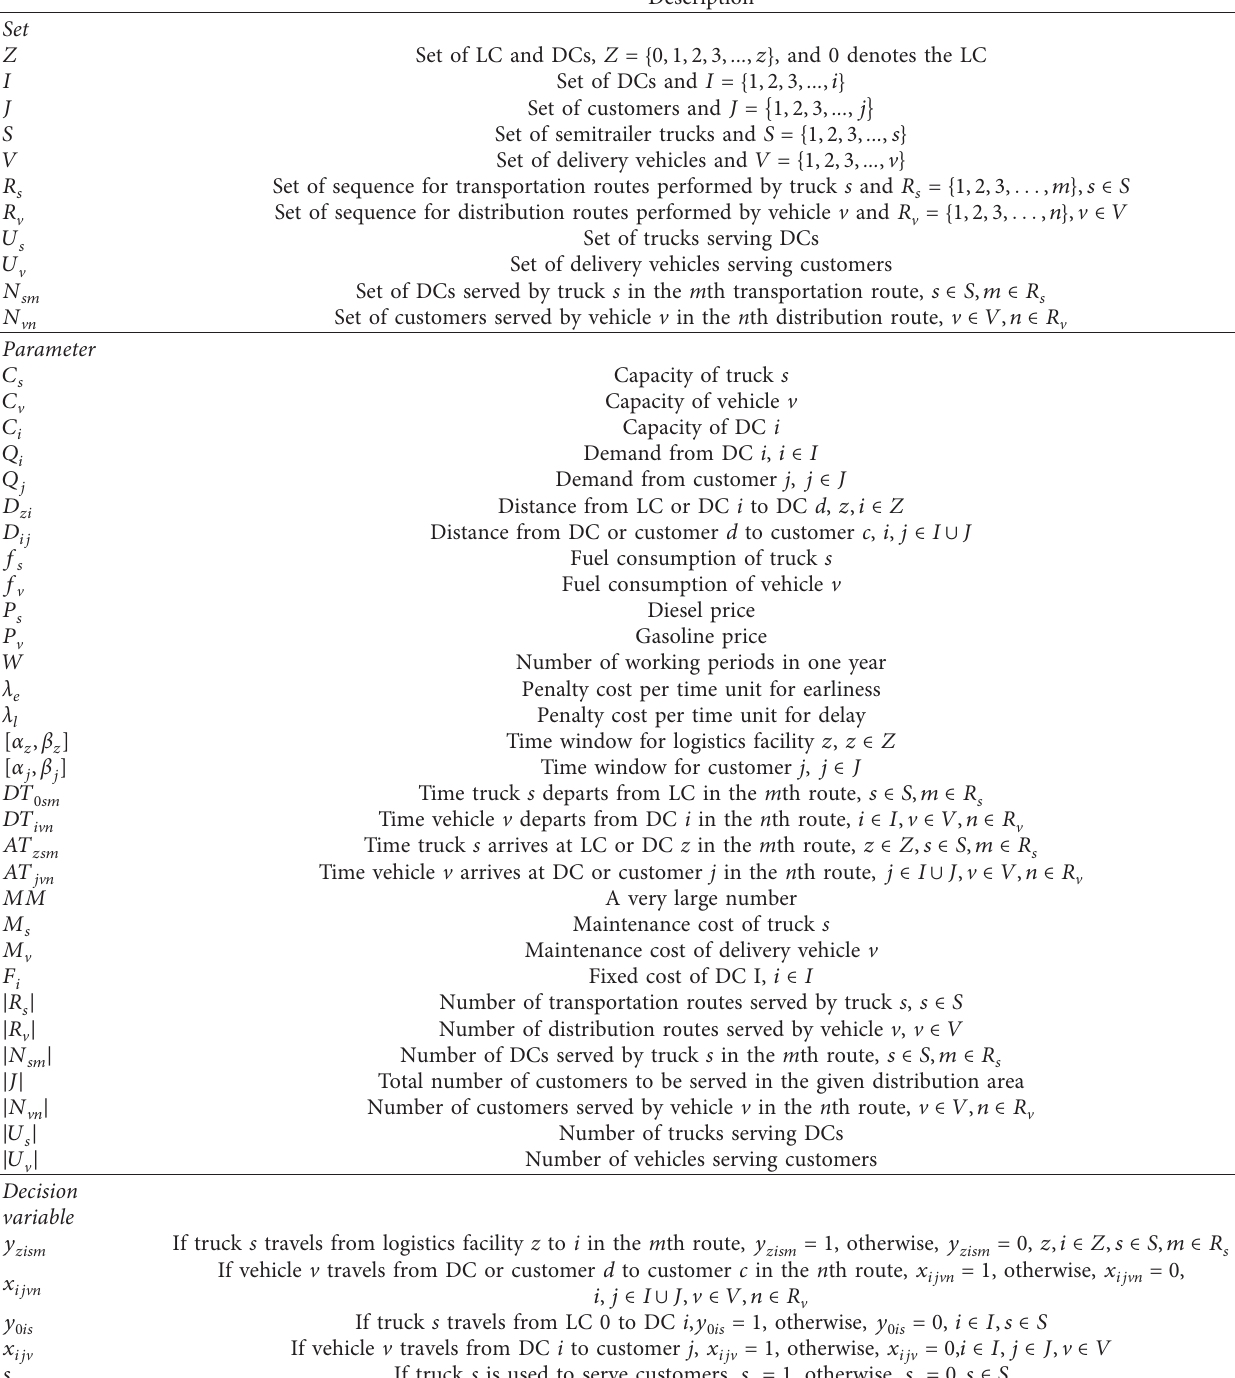
Table 2: Notations and description used in the 2E-LRPTWTRS model.